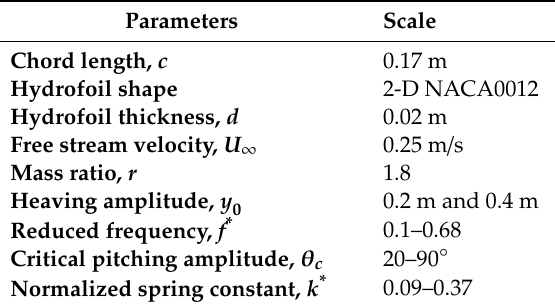
Table 2. The main parameters in the present